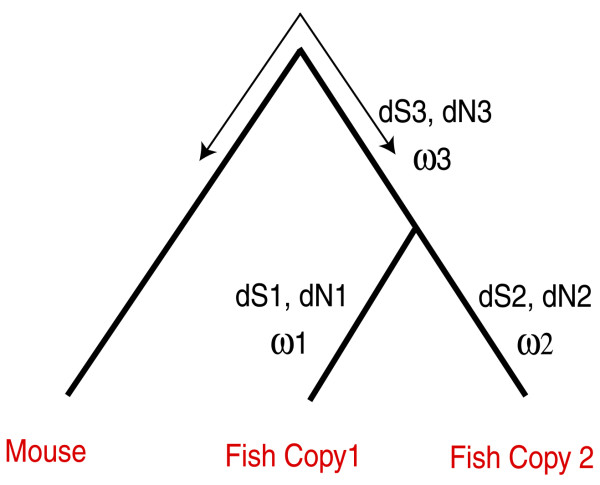
Un-rooted tree topology for the fish gene duplicates and the mouse orthologous gene used as outgroup. Evolutionary rates are obtained for every branch of this tree.